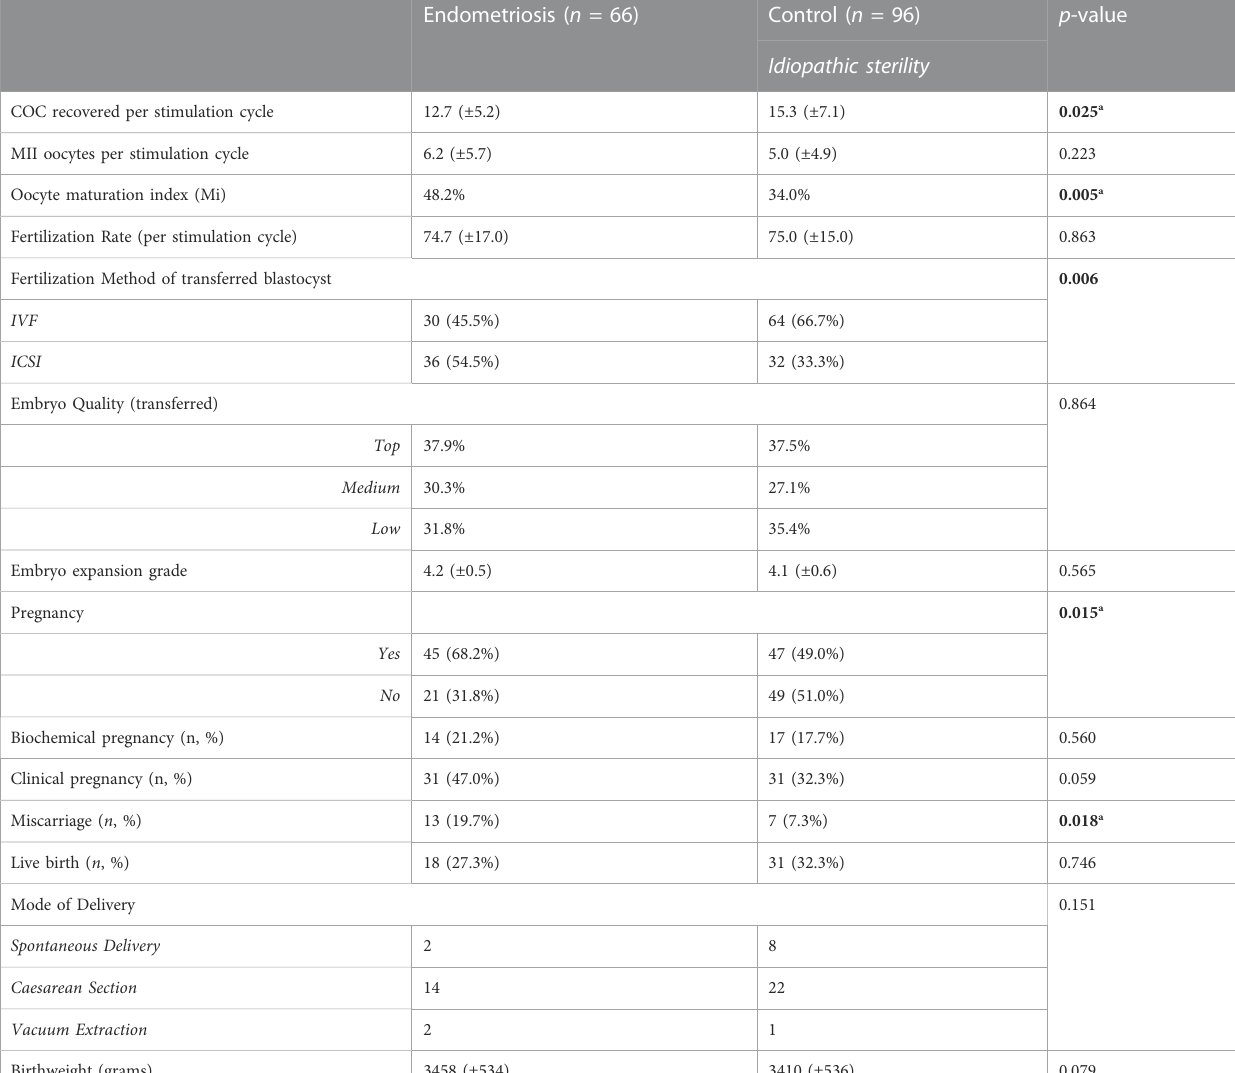
TABLE 2 Treatment cycle primary and secondary